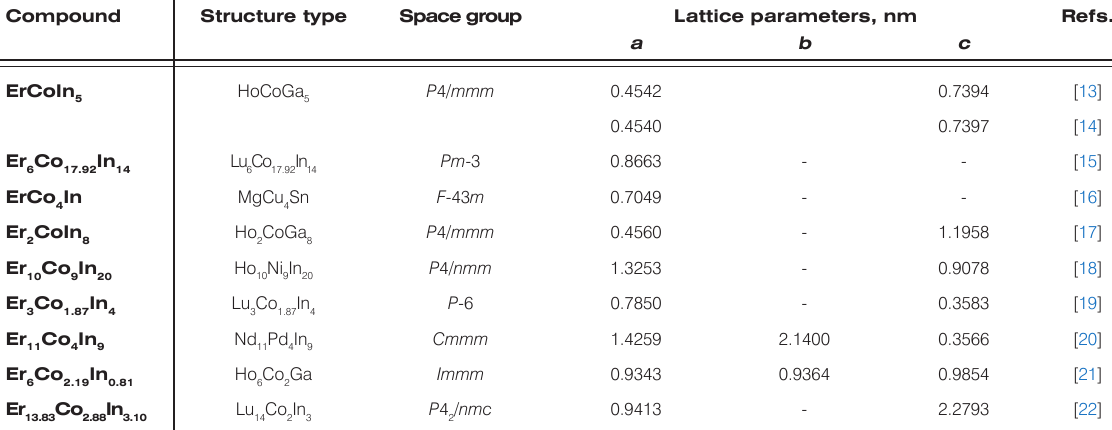
Table 1. Crystallographic characteristics of ternary compounds in the Er-Co-In system.